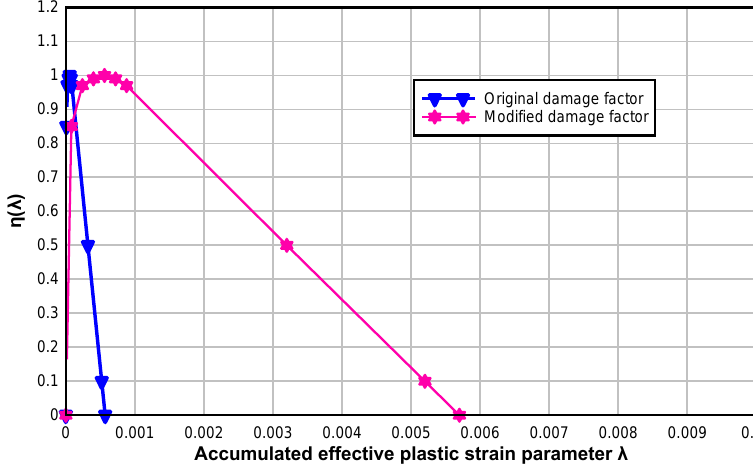
Figure 4. Damage factor used for AC material.